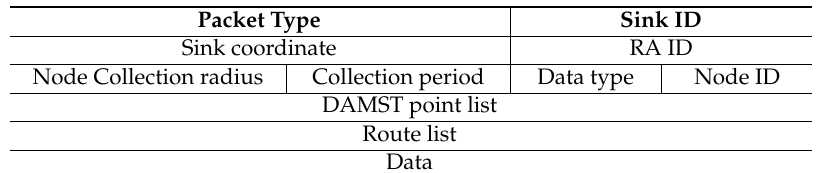
Table 1. Packet format.